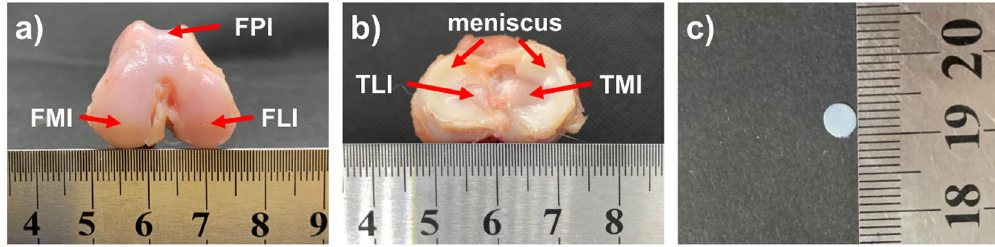
Figure 1. The cartilage samples for unconfined compression tests. The test regions in femur ( a ) and tibia ( b ). ( c ) The photo of cartilage disk